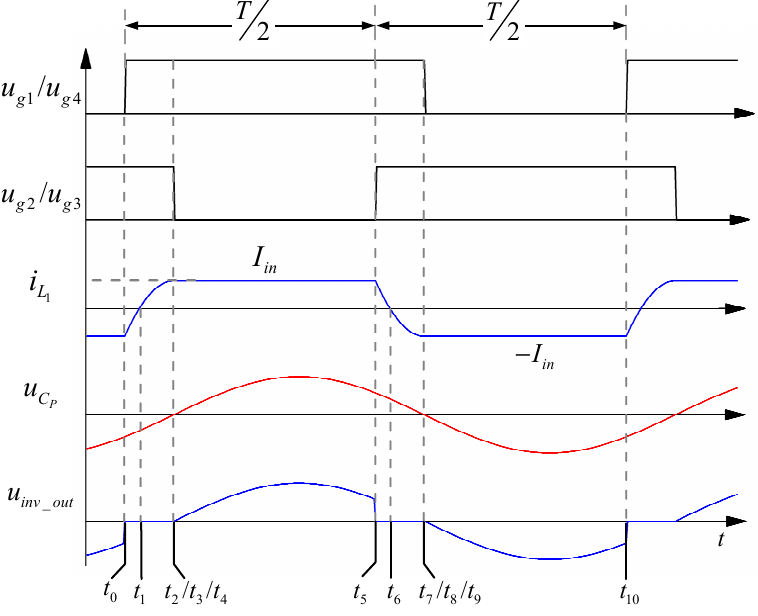
Figure 11. Waveform in the critical mode.